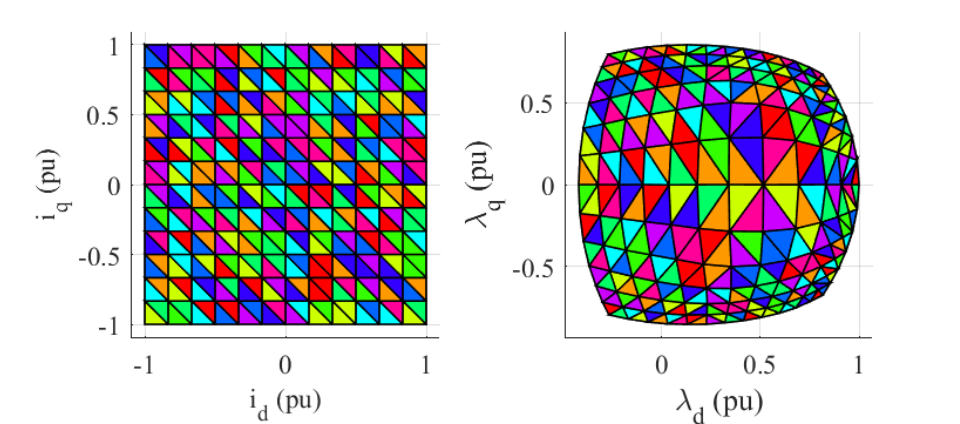
Figure 4. ( left ) Mesh of simplices I j ∈ I M created using a 13-by-13 regularly gridded I P in current space. ( right ) Corresponding mesh of simplices Λ j ∈ Λ M in flux